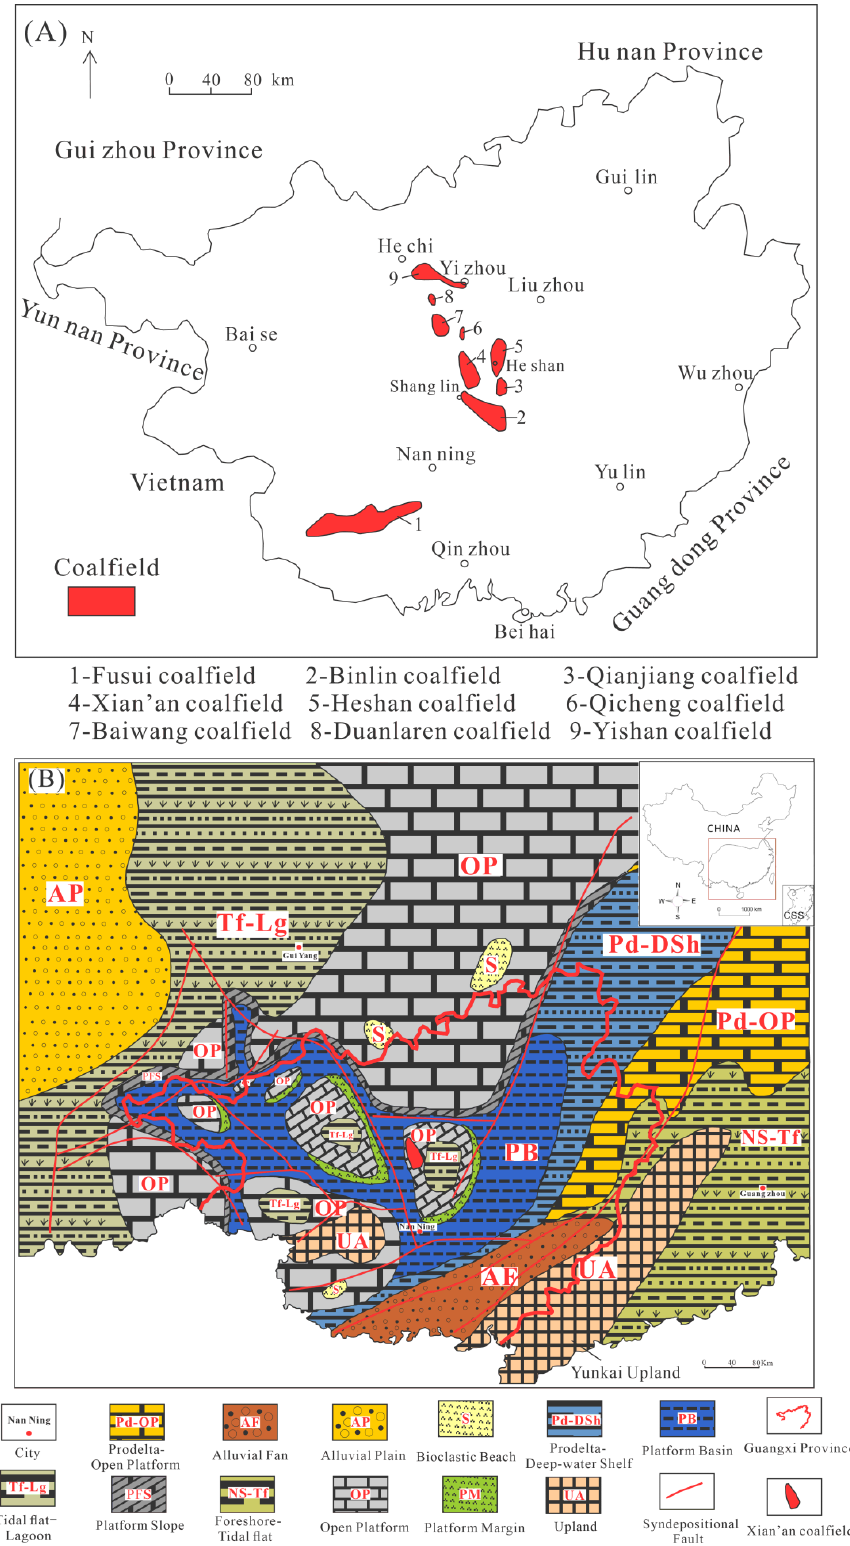
Figure 1. ( A ) Location of coalfields in Guangxi Province [15]; ( B ) location of the Xian’an Coalfield as well as the distribution of Late Permian sedimentary environments in southern China. CSS, China South Sea